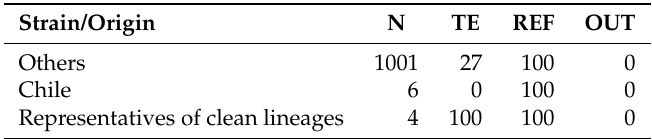
Table 1. Tree topologies comparison considering representative strains (DBVPG1106, DBVPG6044, K12 and YPS128) and Chilean strains. N: Number of strains. TE: Total Evidence phylogenetic tree. REF: Reference phylogenetic tree. OUT: Randomly generated